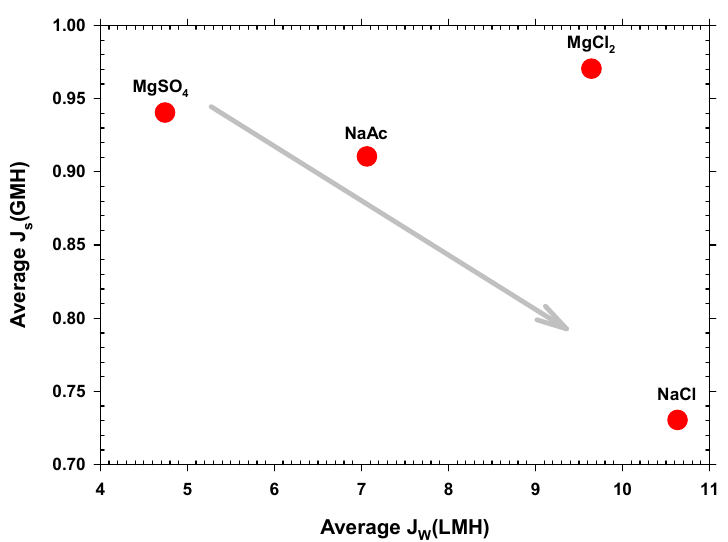
Figure 6. Average reverse salt flux versus each type of draw solution.